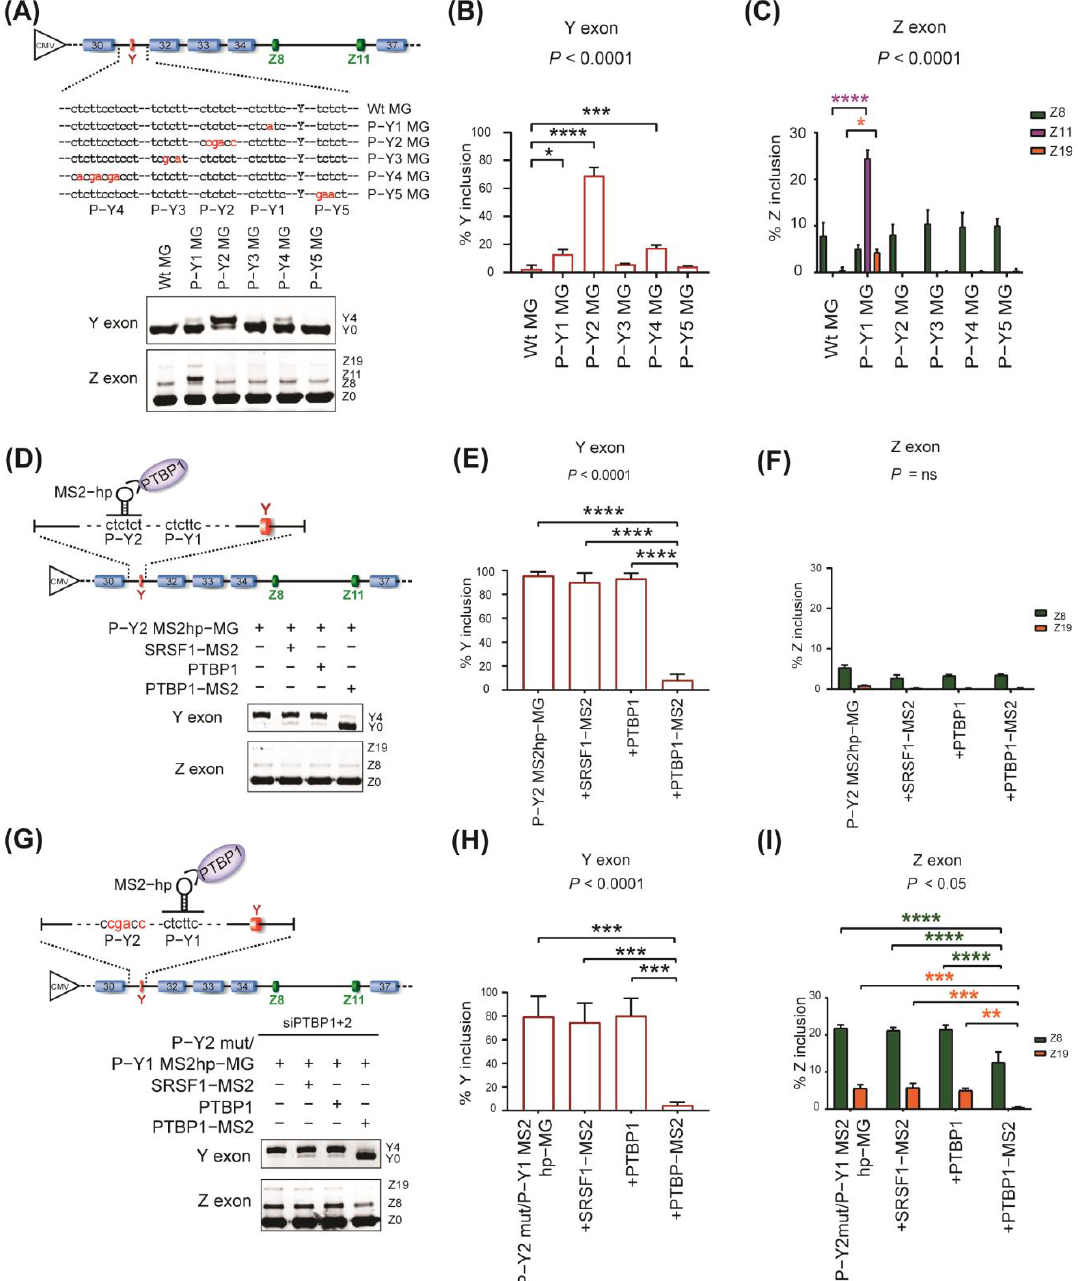
Figure 3. Roles of PTBP1 binding sites around the Y exon for the splicing repression of Y and Z exons. ( A ) Schematic showing wild − type minigene (Wt MG) and mutant minigenes (P − Y1 to P − Y5 MG) carrying mutations at the predicted PTBP1 − binding sites around the Y exon. Mutations are indicated in red. RT − PCR ( bottom panel ) showing splicing of the Y exon and Z exons for wild − type and mutant minigenes in SH − SY5Y cells. ( B , C ) Quantification of ( A ). Mean and SD ( n = 3 independent experiments) of %Y inclusion ( B ) and %Z inclusion ( C ) are indicated. ( D ) Schematic (top) showing artificial tethering of fused PTBP1 − MS2 coat protein (PTBP1 − MS2) to a reporter minigene (P − Y2 MS2hp − MG) carrying an MS2 hairpin loop (MS2hp) at P − Y2. The MS2 hairpin loop is indicated by a stem − and − loop, and the MS2 coat protein is indicated by an inverted U shape. RT − PCR ( bottom panel